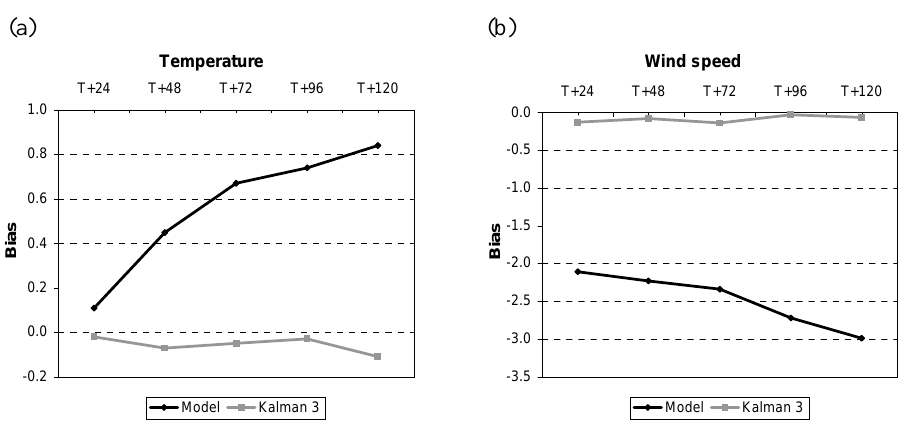
Fig. 6. Standard deviation of bias for temperature and wind speed for model and different Kalman filters outputs in (a) Case I and (b) Case II.